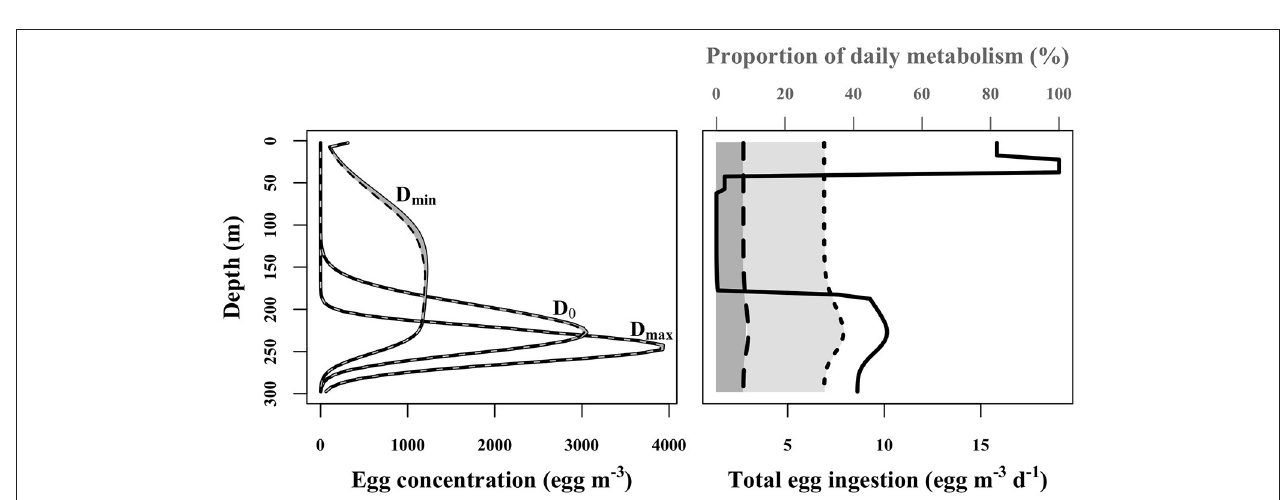
FIGURE 7 | Simulated egg concentration profiles for three different scenarios (scenario D min , D 0 , and D max ; left panel). Solid line is without female M. longa intraguild predation, dashed line is with intraguild predation and the gray area is the difference between both. On the right panel, solid line is the C. hyperboreus egg biomass ingested by the population of female M. longa (egg m − 3 d − 1 ) according to the simulated egg concentration with scenario D 0 and M. longa abundance profile presented in Figure 4 . Proportion of individual daily metabolic needs satisfied by egg ingestion (%) according to respiration rates from Seuthe et al. (2006; Dashed line) and Hirche (1987; Dotted